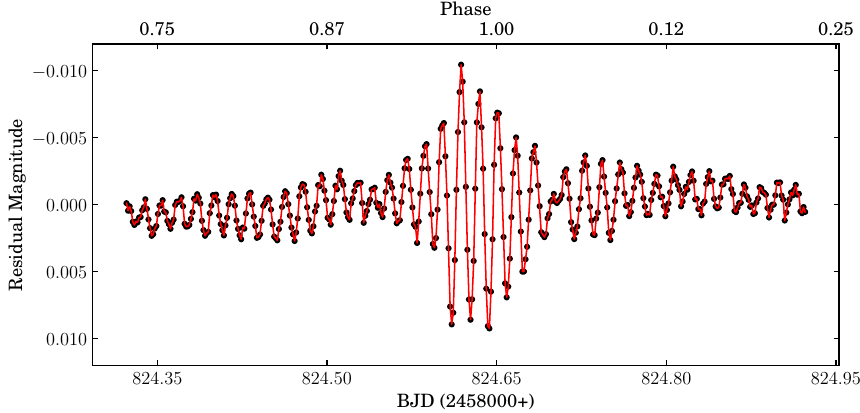
Figure 6. A portion of the TESS residual light curve of RZ Cas around the primary minimum at BJD=2458824.6540, displaying the amplitude amplification due to the PSF